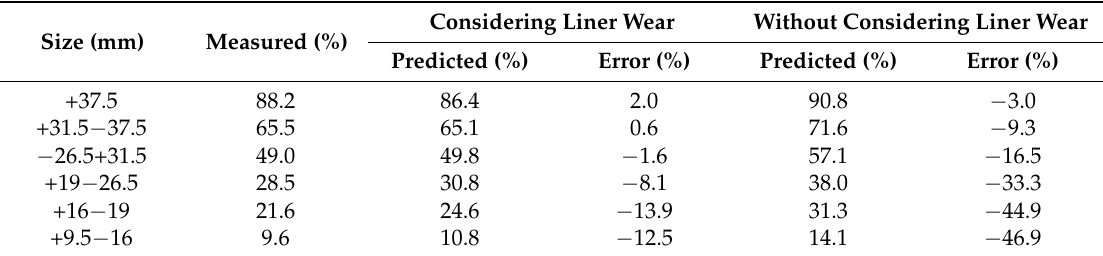
Table 2. Comparison between measured and predicted results of the particle size distribution (PSD).